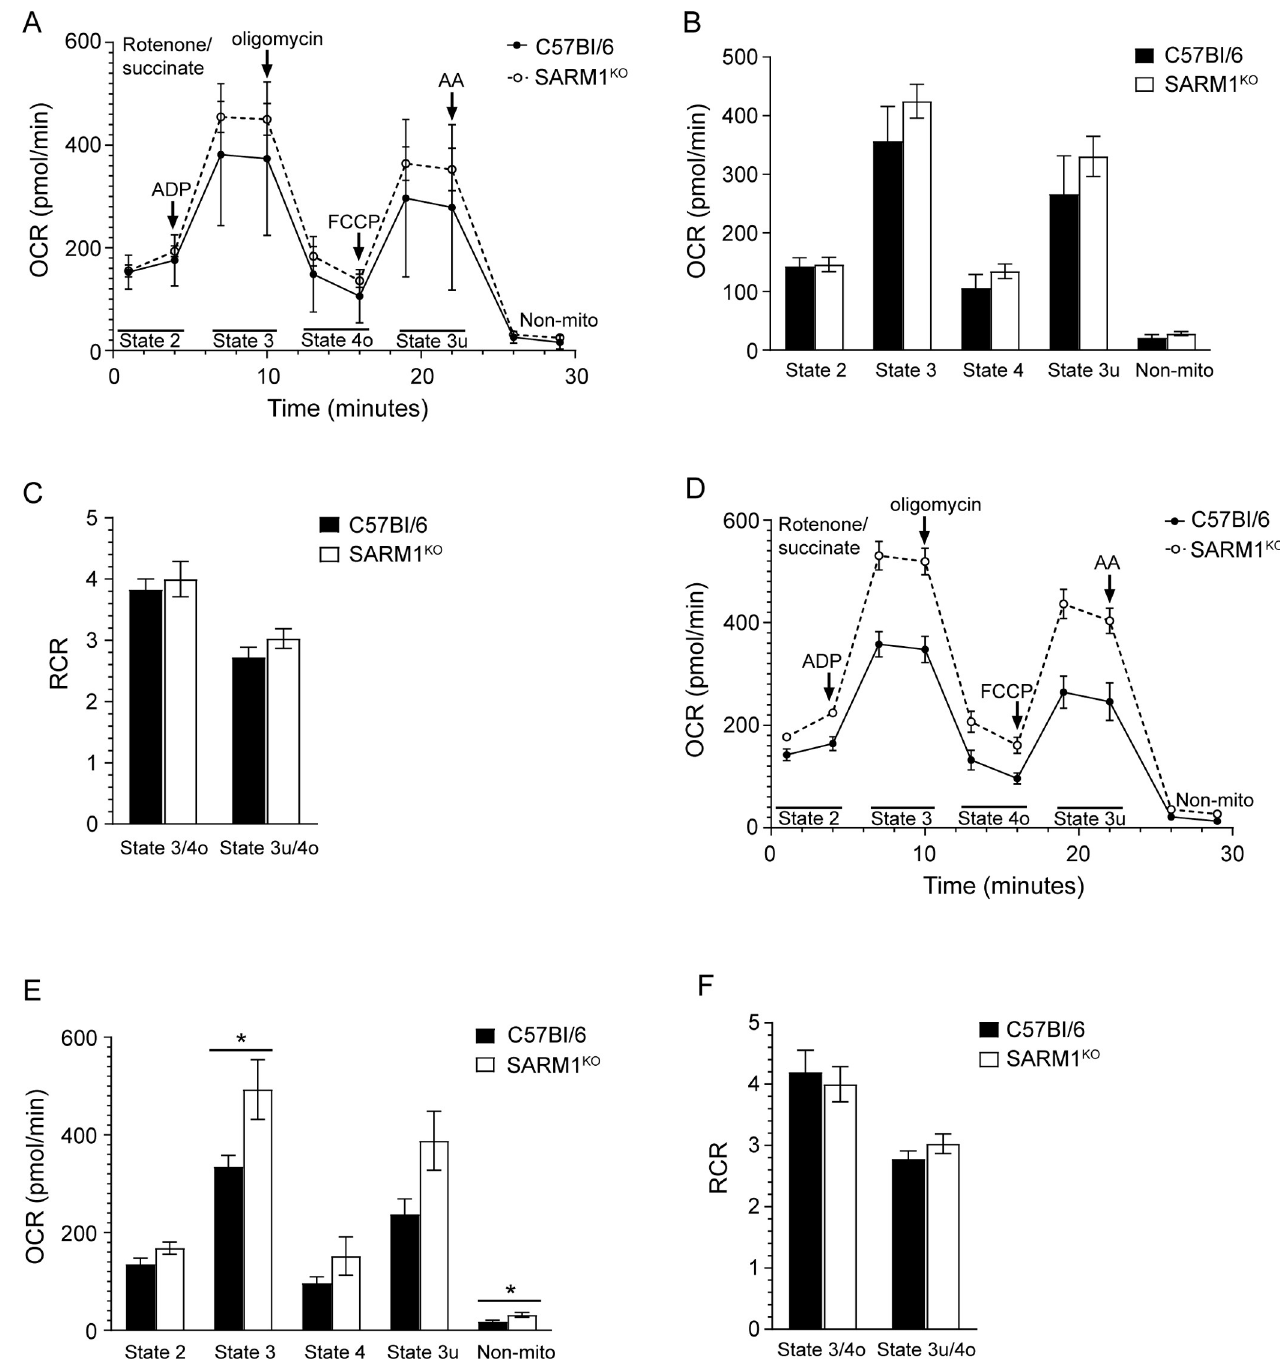
Fig 8. Increased State 3 OCR in RML prion infected SARM1 KO mice compared to RML prion infected C57Bl/6 mice. (A) Mitochondrial coupling assay measuring mitochondrial respiration for C57Bl/6 (n = 5; black circle, solid line) and SARM1 KO (n = 6; open circle, dotted line) mice inoculated with NBH. The reagents added during the 30 min assay as well as the states quantified are indicated. AA = antimycin A; Non-mito = non mitochondrial respiration. (B) OCRs and (C) RCRs for the data in Panel A. Data were calculated as described in the materials and methods. Black bars = C57BL/6, white bars = SARM1 KO . (D) Mitochondrial coupling assay measuring mitochondrial respiration for C57Bl/6 (n = 5; black circle, solid line) and SARM1 KO (n = 6; open circle, dotted line) mice infected with RML prions. (B) OCRs and (C) RCRs for the data in Panel D. Values were calculated as described in the materials and methods. Black bars = C57BL/6, white bars = SARM1 KO . For all panels, data are derived from Figs 6 and 7, with the mean ± SEM shown. Statistical significance was calculated using the unpaired Student’s t-test with Welch’s correction. � p = 0.05.